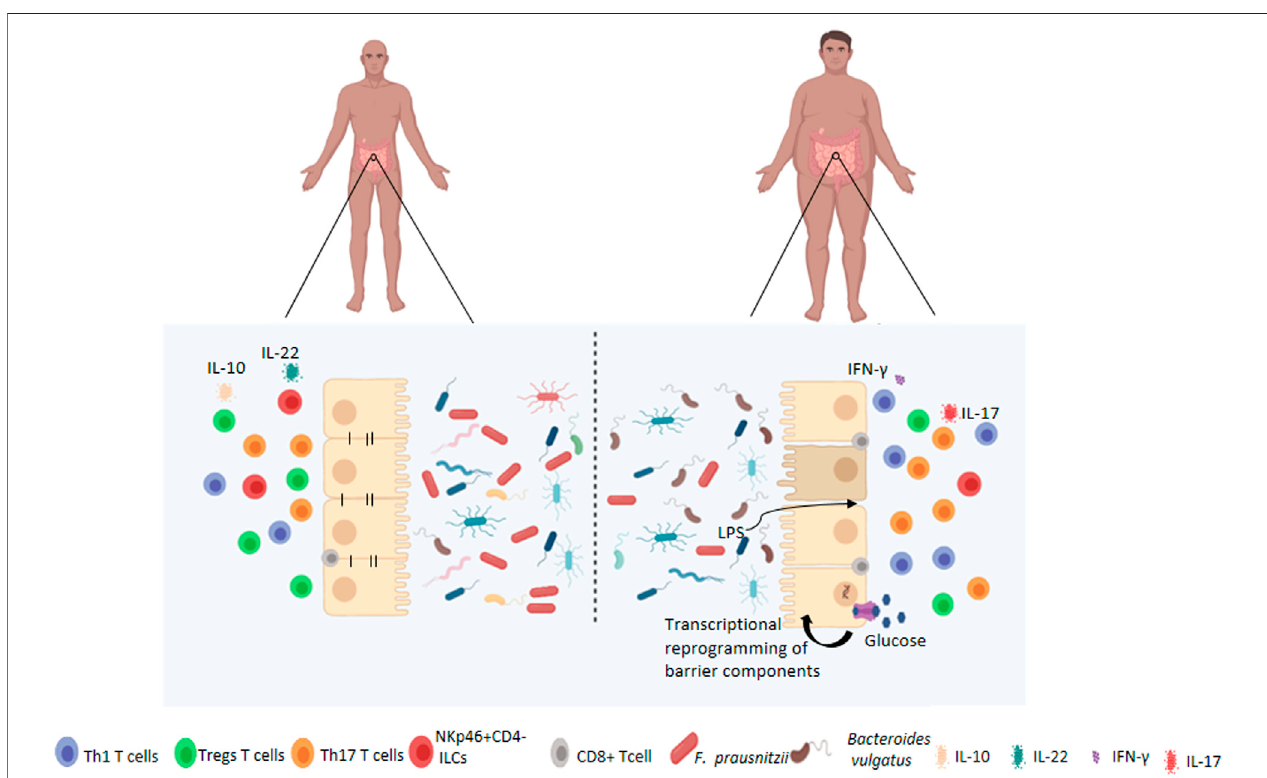
FIGURE 1 | Changes to the intestinal barrier functions associated with obesity. Under normal circumstances, the gut microbiota is highly diversi fi ed which contributes to the maintenance of intestinal permeability, tolerance to dietary antigens and immunoregulation. Obese patients have dysbiosis of the gut microbiota, characterised by decreased diversity, and altered barrier functions such as increased permeability and activation of pro-in fl ammatory pathways by immune cells at local and systemic levels. Obesity-associated hyperglycemia may also drive barrier permeability through transcriptional reprogramming resulting in decreased expression of adherens and tight juction